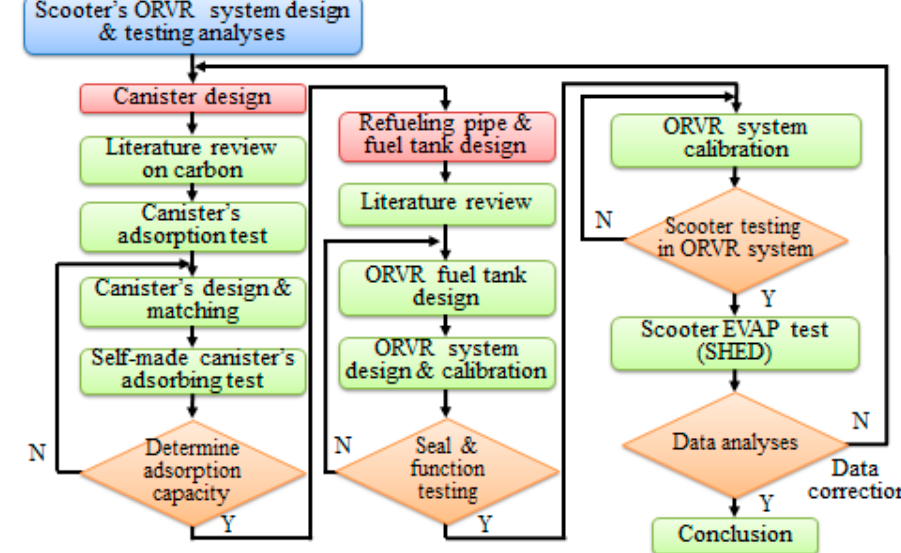
Figure 2. The flow chart of design process and experimental test for the ORVR system for scooters.